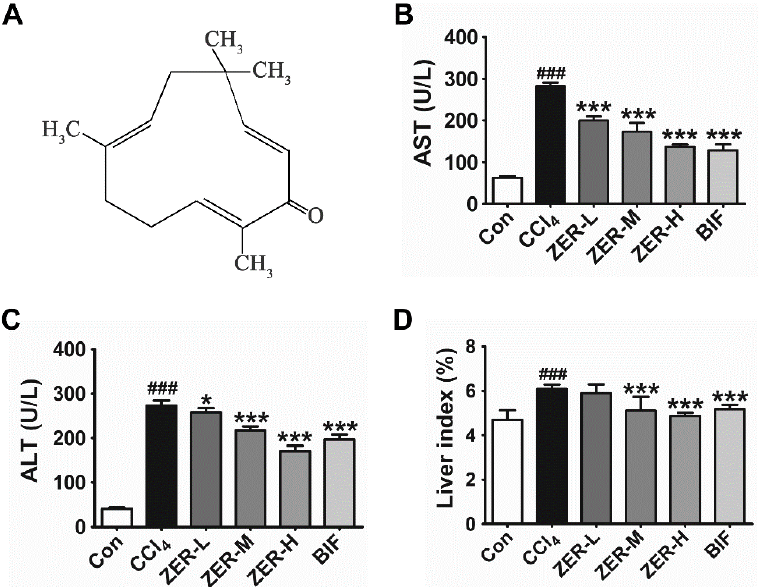
Figure 1. The structure of ZER ( A ) and the inhibitory effects of ZER on serum aspartate aminotransferase AST ( B ), alanine aminotransferase ALT ( C ), and liver index ( D ) on CCl 4 -induced acute liver injury (ALI) in mice. ZER-L, low dose group; ZER-M, medium dose group; ZER-L, high dose group. Values represent the mean ± SD ( n = 10). ### P < 0.001 compared with the control group; * P < 0.05 and *** P < 0.001 compared with the CCl 4 -treated group.